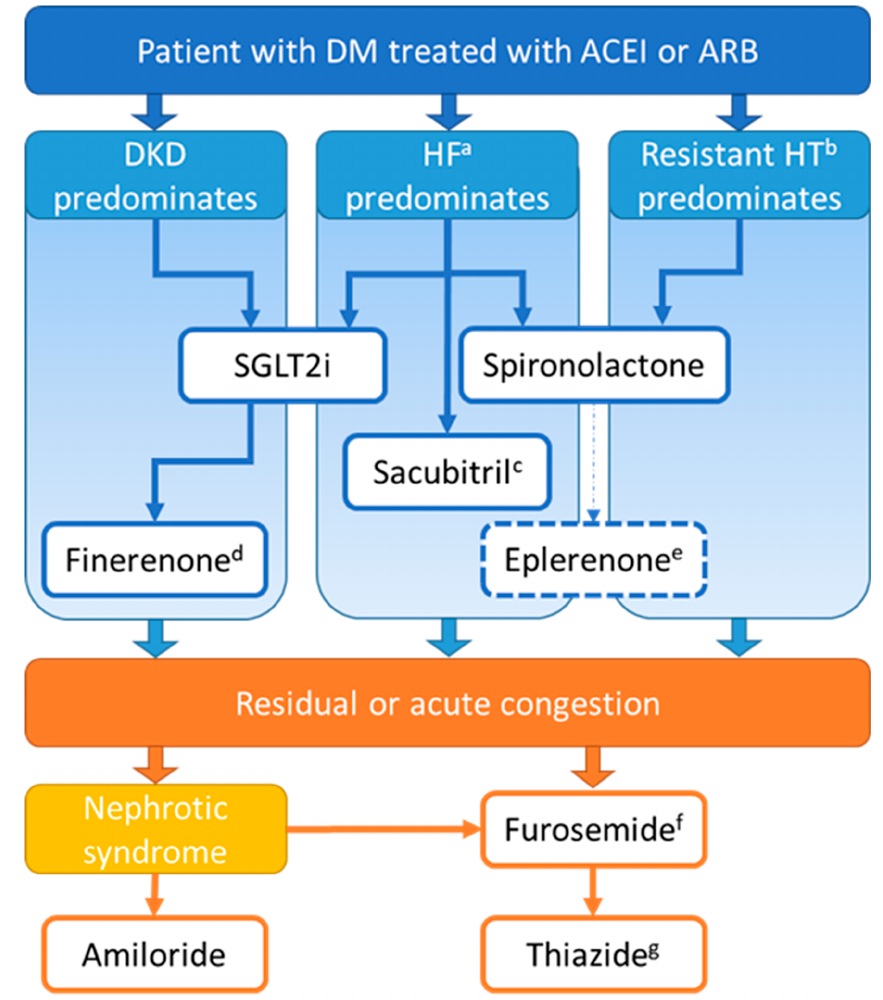
Figure 4. Suggested evidence-based approach for diuretic combinations in patients with diabetes mellitus treated with an angiotensin converting enzyme inhibitor or an angiotensin receptor blocker. a: especially with reduced ejection fraction. b: above-goal elevated blood pressure despite concurrent use of three antihypertensive drug classes (consider secondary hypertension assessment). c: discon- tinue ACEI or ARB before starting sacubitril/valsartan. d: if persistent proteinuria despite SGLT2i, consider adding finerenone. e: if endocrine adverse drug reactions are an issue, consider switching from spironolactone to eplerenone. f: for other loop diuretics; consider down-titrating to minimal effective dose after the emergency phase. g: e.g., hydrochlorothiazide or indapamide. DM: diabetes mellitus, ACEI: angiotensin converting enzyme inhibitor, ARB: angiotensin receptor blocker, DKD: diabetic kidney disease, HF: heart failure, HTA: